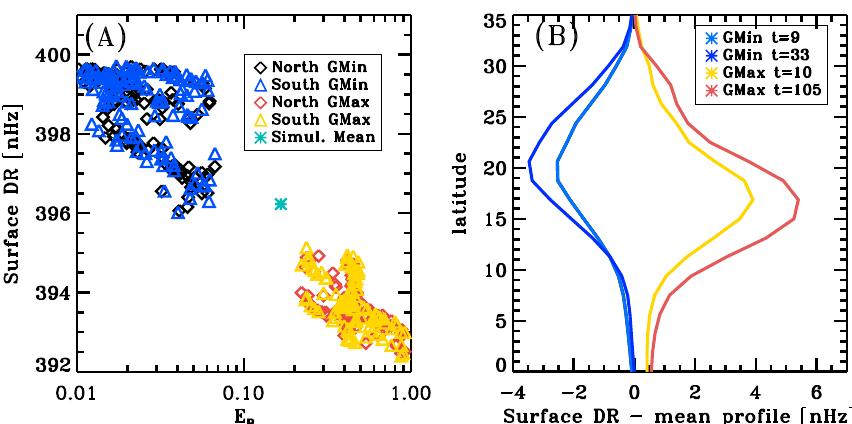
Fig. 13. (A) Difference in surface angular velocity between the equator and latitude 20 (cid:3) latitude for every Grand Maxima (Minima) in red and yellow (blue and black) measured in simulation, i.e., at extrema of the time series plotted on Figure 12A. The green asterisk indicates the simulation mean for this quantity. (B) Surface differential rotation against latitude for two grand maxima in red and two grand minima in blue, with the simulation mean again